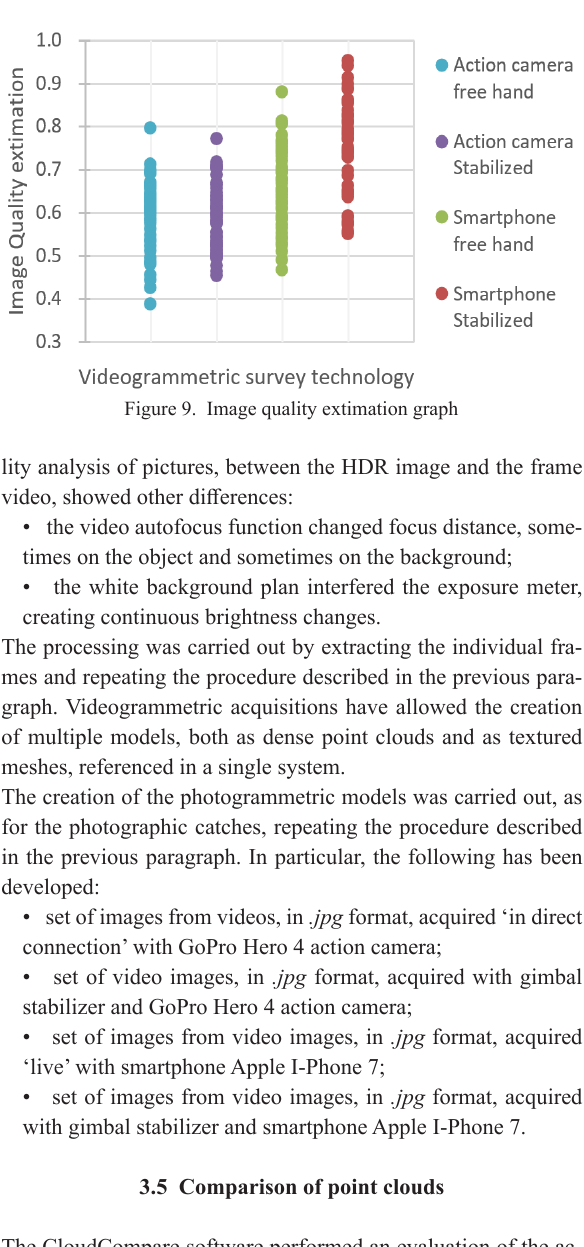
Figure 8. The trend of the similarity parameter